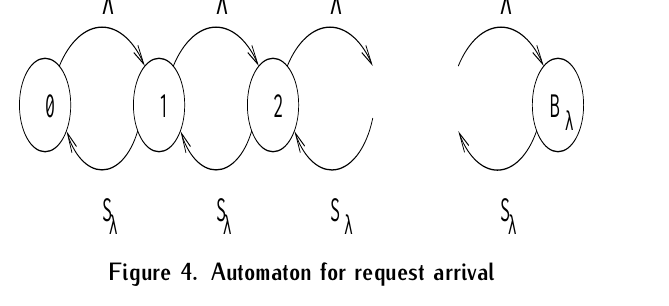
Figure 4. Automaton for request arrival